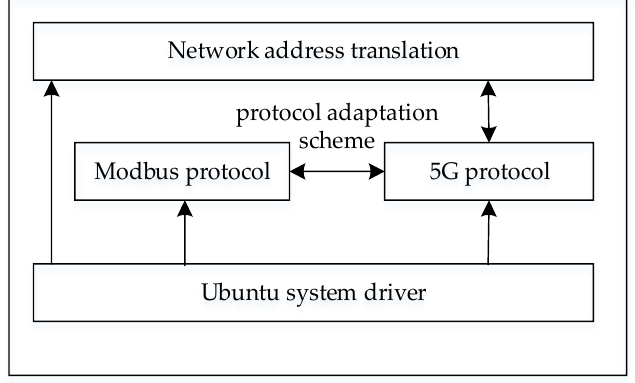
Figure 12. The software architecture of wireless PLC prototype.